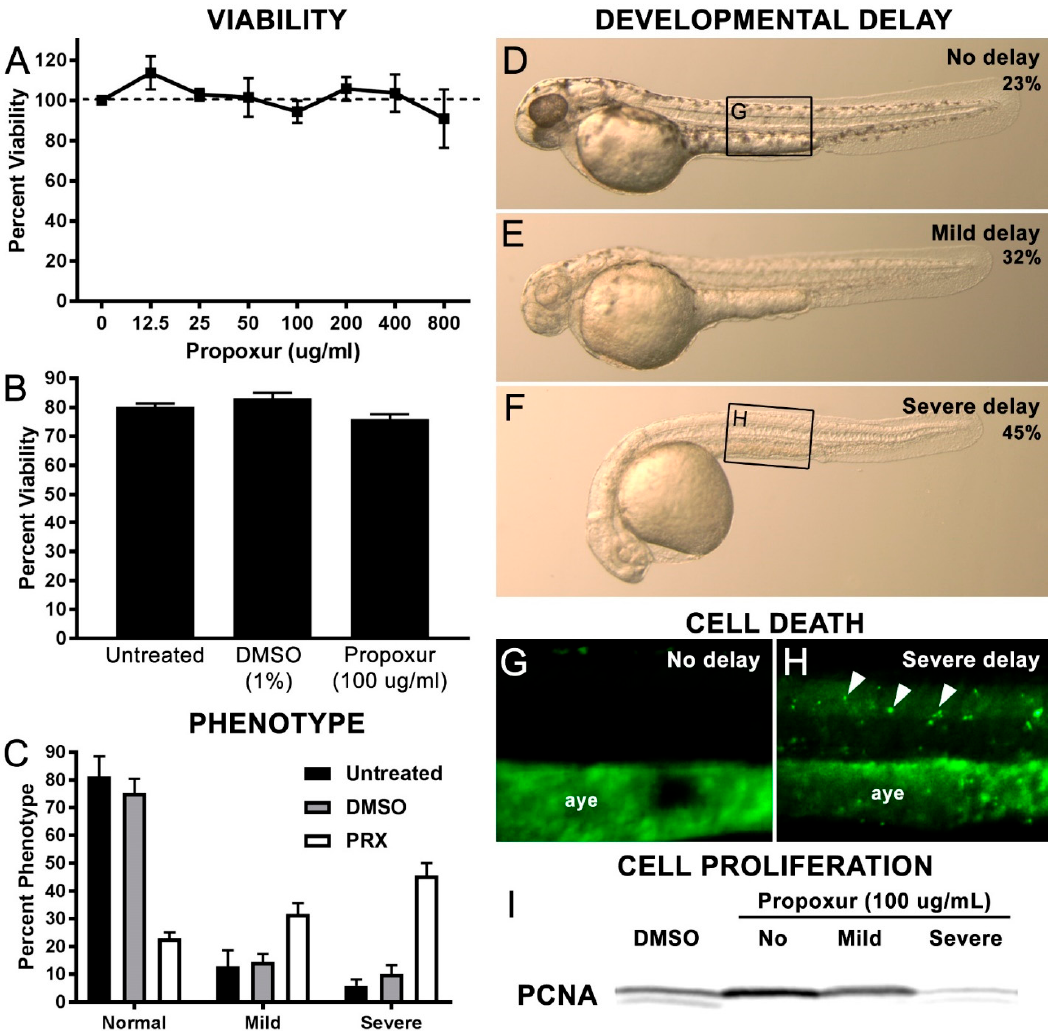
Figure 1. Propoxur exposure during zebrafish development results in three distinct developmental delay phenotypes: ( A ) Percent viability of treated embryos at varying propoxur concentrations; ( B ) percent viability of embryos in untreated, 1% DMSO-treated, and 100 ug / mL propoxur-treated groups; ( C ) percent of delay phenotypes present in untreated, DMSO-treated, or propoxur-treated groups; visual representation of phenotypic groups at 40 hpf: ( D ) no delay, ( E ) mild delay, and ( F ) severe delay. ( G , H ) Acridine orange uptake shows an increase in fluorescent puncta (arrowheads) associated with the severe delay group compared with the no delay group. These puncta are distinct from the autofluorescence observed in the anal yolk extension (aye) in both groups. The panel insets for Figure 1G,H are shown in Figure 1D,F, respectively; ( I ) Western blot analysis of the G1 / S